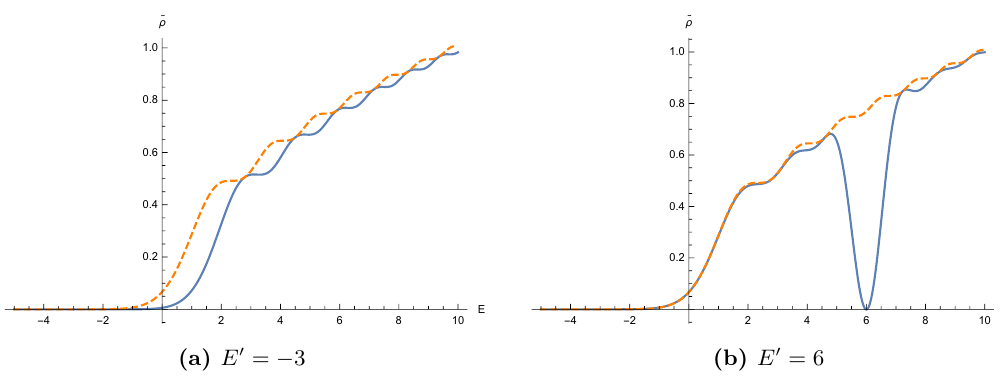
Figure 5. Plot of ρ ( E, E 0 ) in (6.17) for a E 0 = − 3 and b E 0 = 6 , as a function of E . The solid e curves are the deformed eigenvalue density ρ ( E, E 0 ) while the orange dashed curve represents the e original eigenvalue density ρ ( E ) = K ( − E, − E ) without FZZT e